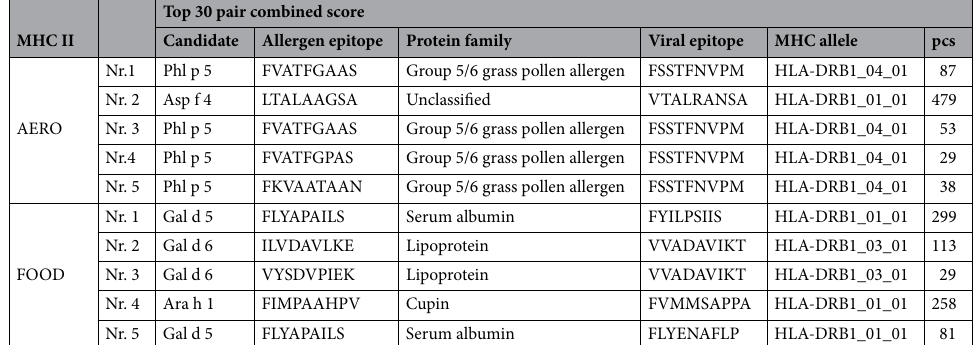
Table 2. The Top 5 candidate human HLA class II T cell potentially cross-reactive epitope pairs between SARS-CoV-2 and aero-and food-allergens based on pair combined score and application of additional clinical and conservation related criteria (see Fig. 1) (pipeline 1) Pcs = pair combined score.